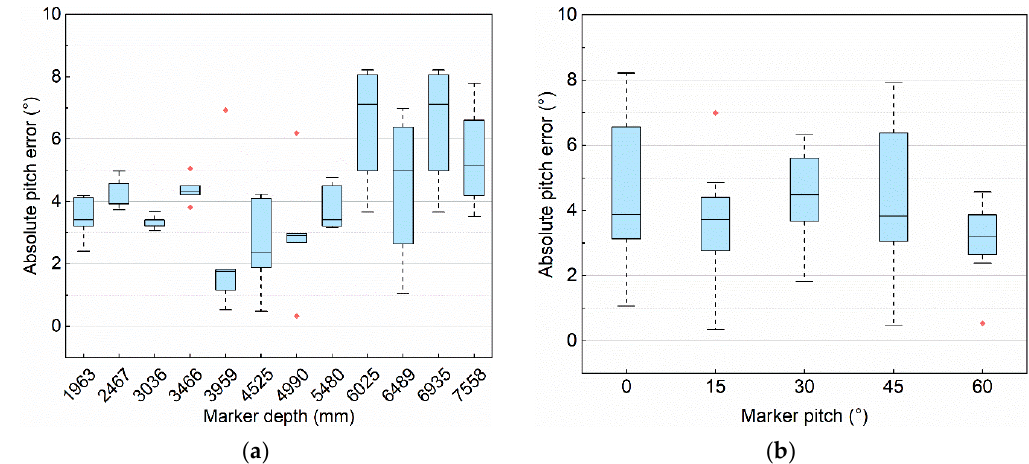
Figure 8. The absolute pitch error with different configurations. ( a ) Absolute pitch error under different marker depths. ( b ) Absolute pitch error under different marker pitches.